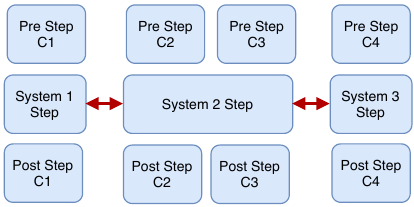
Figure 6. Parallel solution of decoupled